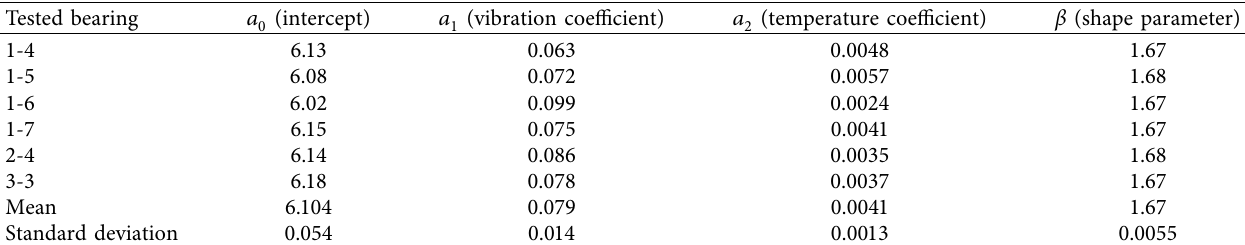
Table 3: Model parameters for various training data sets under vibration and temperature fuzzy operators. Tested